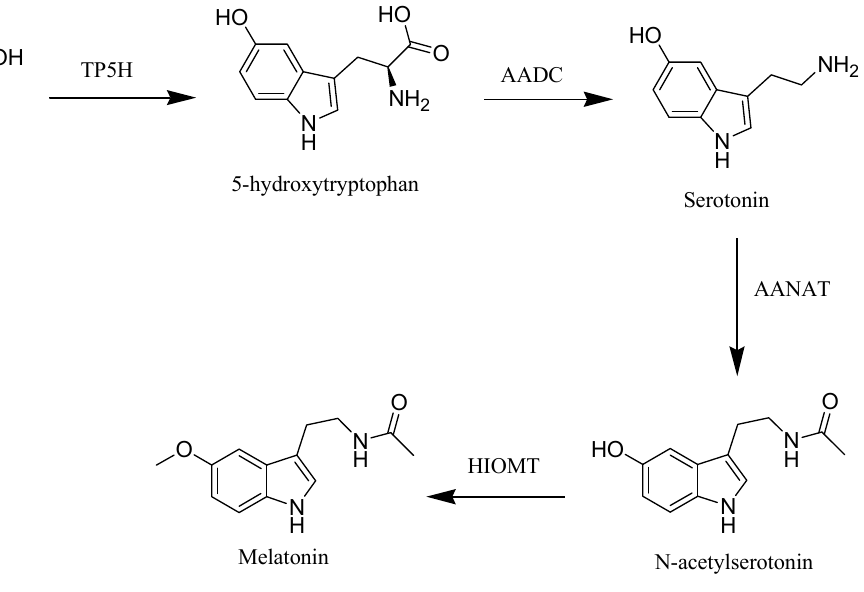
Figure 1. Melatonin biosynthesis in human.